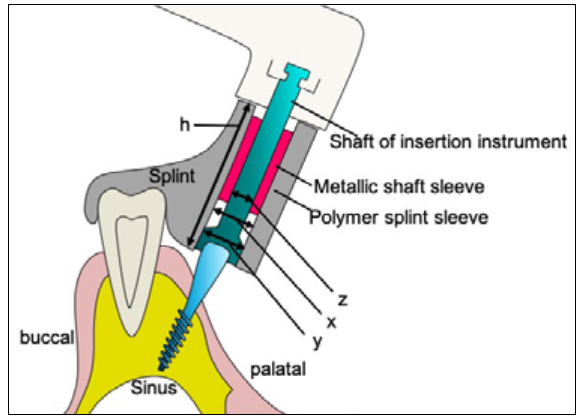
Figure 1. The image depicts the surgical procedure with the designed splint to determine the depth and angulation. (h: polymer sleeve height; x: inner diameter of the polymer splint sleeve; y: diameter of the insertion instrument; z: inner diameter of the metallic shaft sleeve).